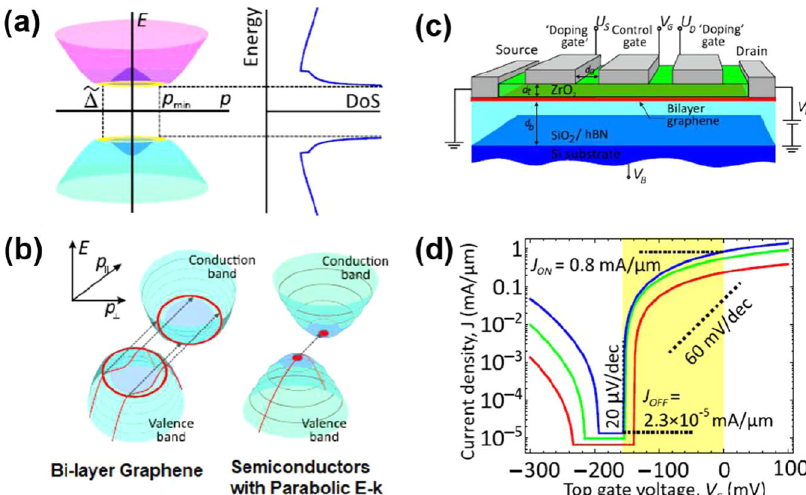
Fig. 7 Simulation Report of Nanoscale 2D GrNR-TFET. a Plots of “ Mexican hat ” feature in E-p dispersion relation and subsequent density of states pro fi les near CBM and VBM of 2L-Gr, b electronic states distribution (highlighted in red) under CBM and VBM overlap during BTBT in Gr- Bl, and parabolic band semiconductors c schematics and d transfer characteristics of electrostatically doped 2l-Gr TFET, adapted with permission from 74 . Copyright (2016) Nature.